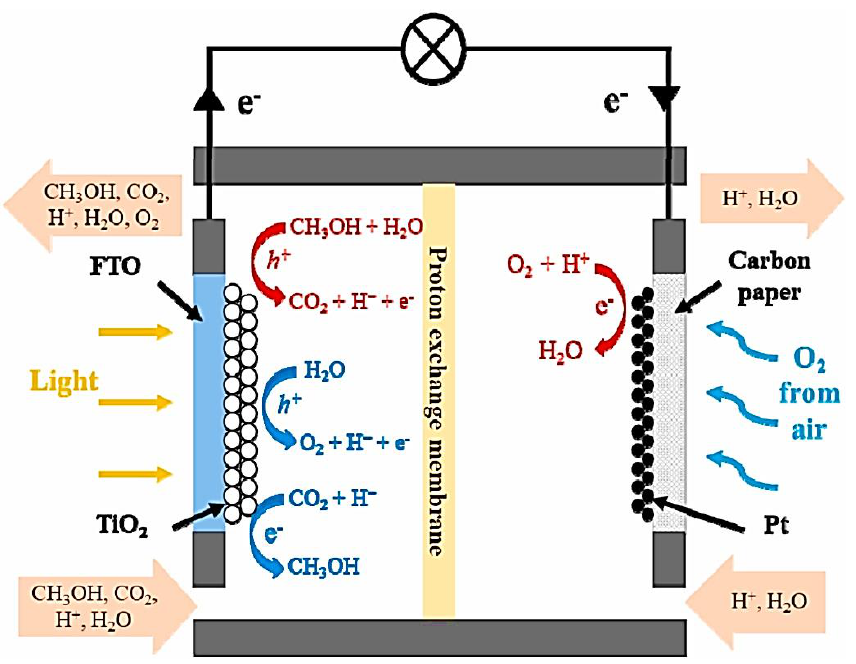
Figure 4. Schematic illustration of a PFC operating with the CO 2 saturated methanol-H 2 SO 4 solution. Reprinted with the permission form ref. [110]. Copyright 2021 Elsevier B.V.